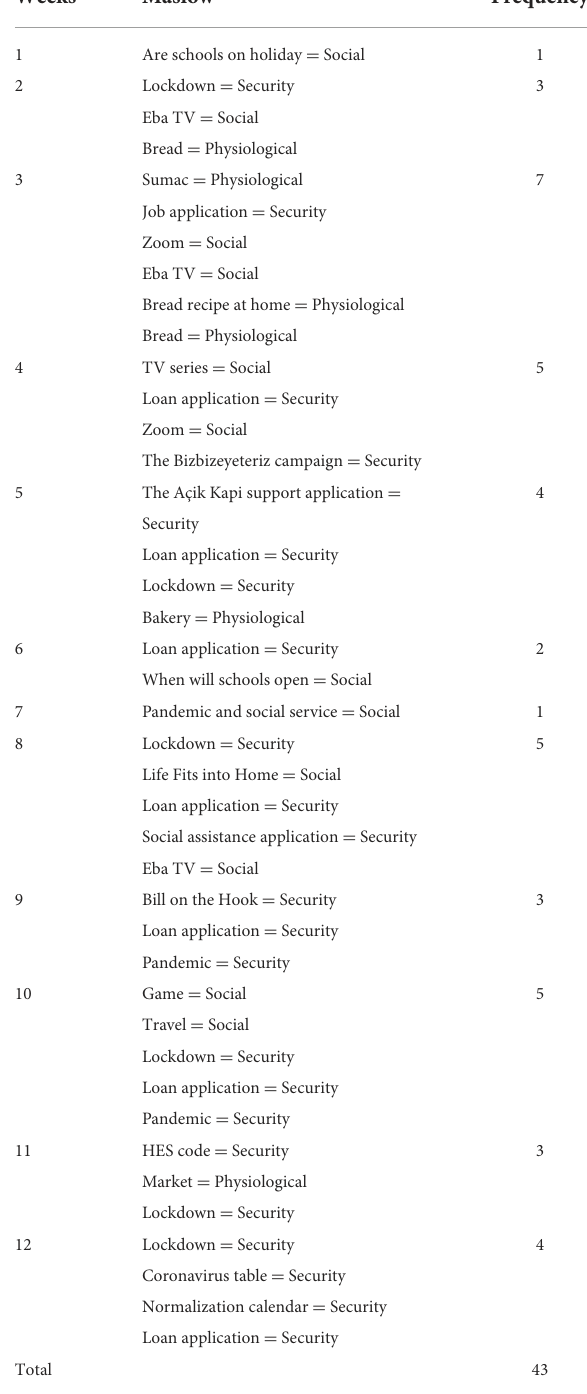
TABLE 2 Matching other concepts related to COVID-19 with Maslow’s hierarchy of